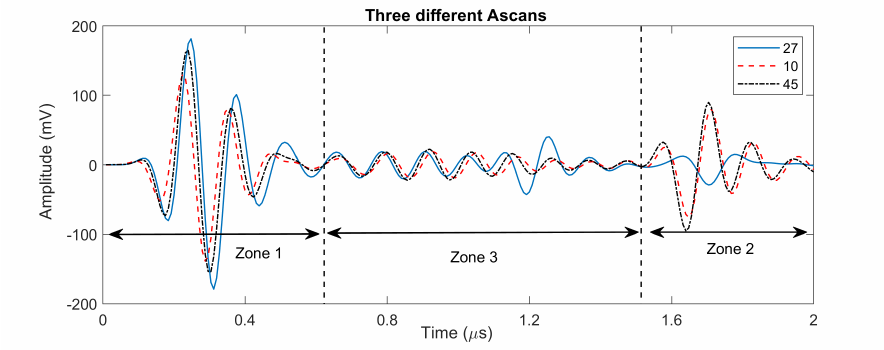
Figure 10. Zones 1, 2 and 3 for three different A-scans with and without